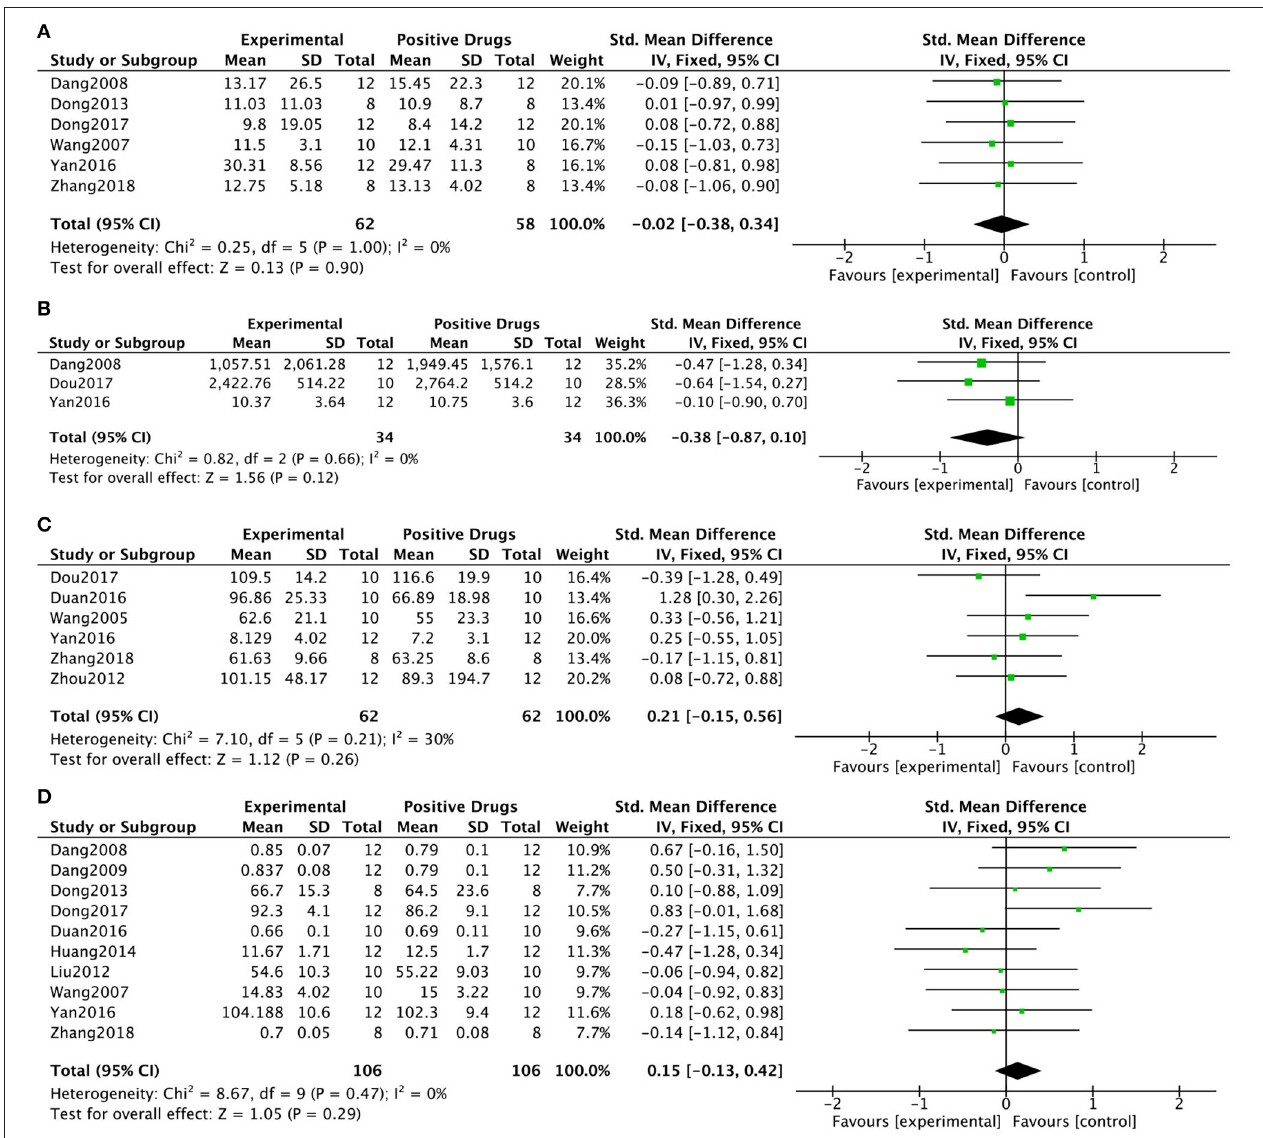
FIGURE 4 | Forest plot showing that KXS showed no significant difference compared with other drugs on the number of rearing events (A) and total distance (B) in the open-field test; There were no differences in duration of immobility in the forced swimming test (C) ; There were no differences in sucrose consumption in the sucrose preference test (D)